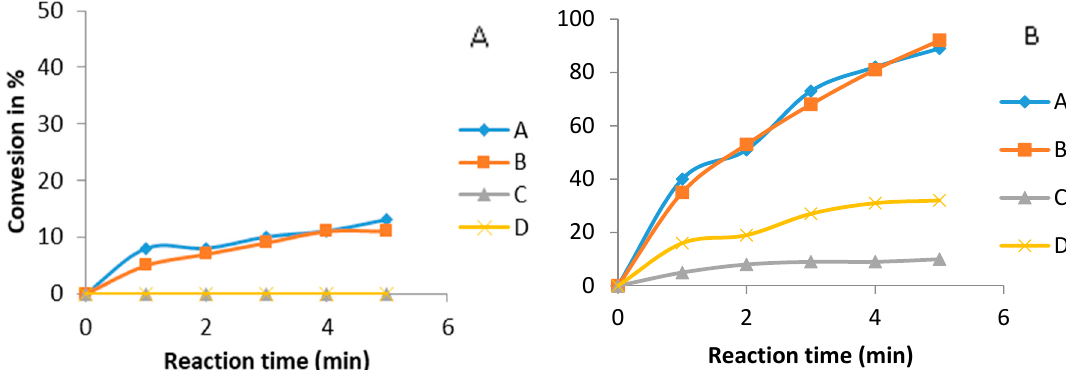
Figure 8. Biodiesel production under various guanidines (3% mol). ( A ) Mechanical stirring batch reactor: (methanol:canola oil) 4:1, temperature 65 °C; ( B ) Ultrasound batch reactor: (methanol:canola oil) 4:1, 60% US amplitude, temperature 35 °C.